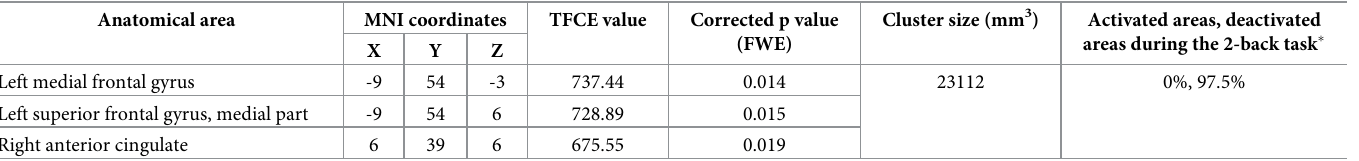
Table 5. Brain regions exhibiting significant positive correlations with IAT score. Anatomical area